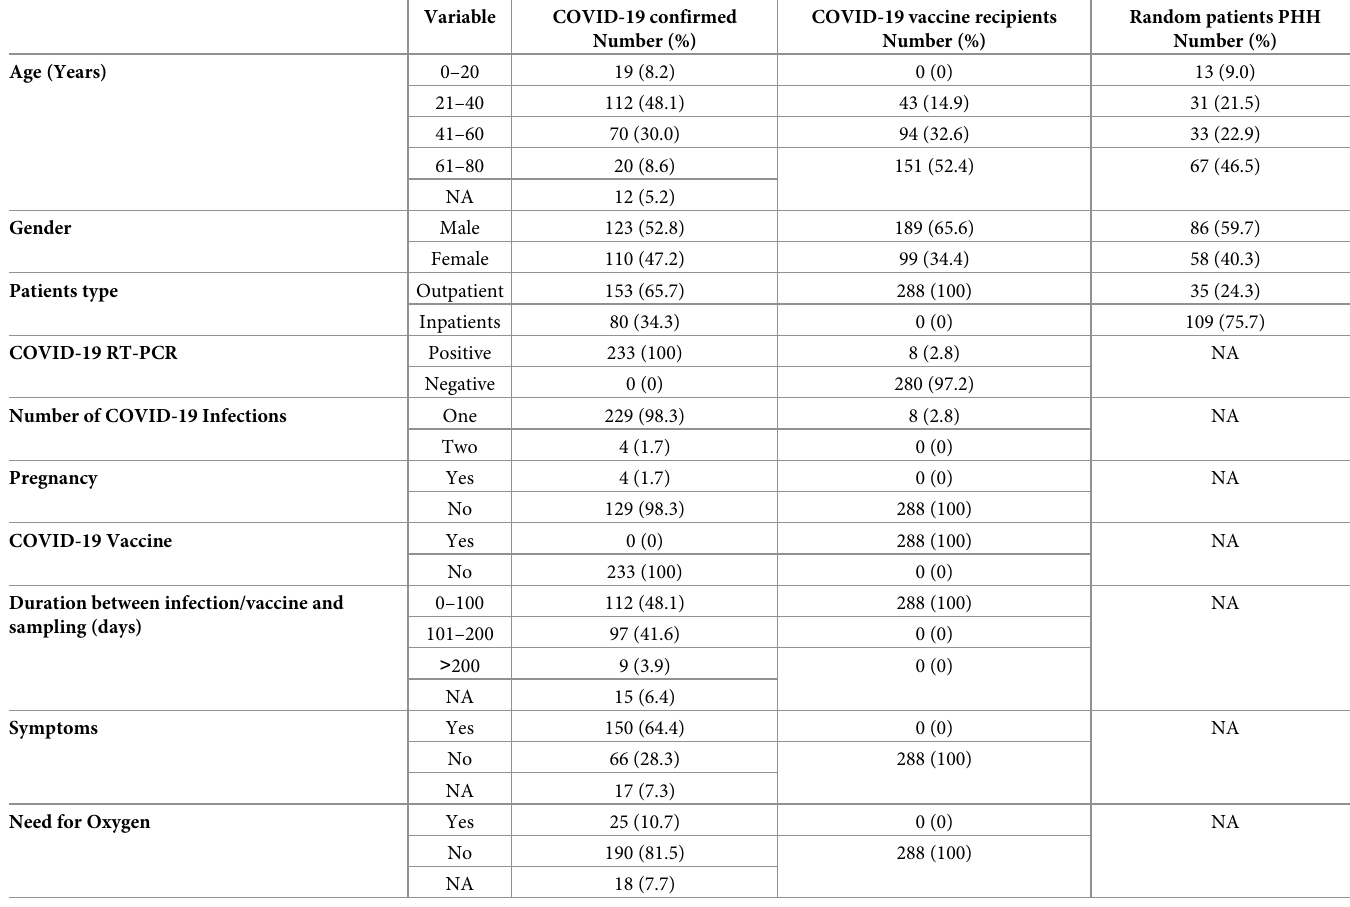
Table 1. Demographic and clinical data of COVID-19 patients (n = 233), COVID-19 vaccine recipients (n = 288), and random patients from PHH (n =